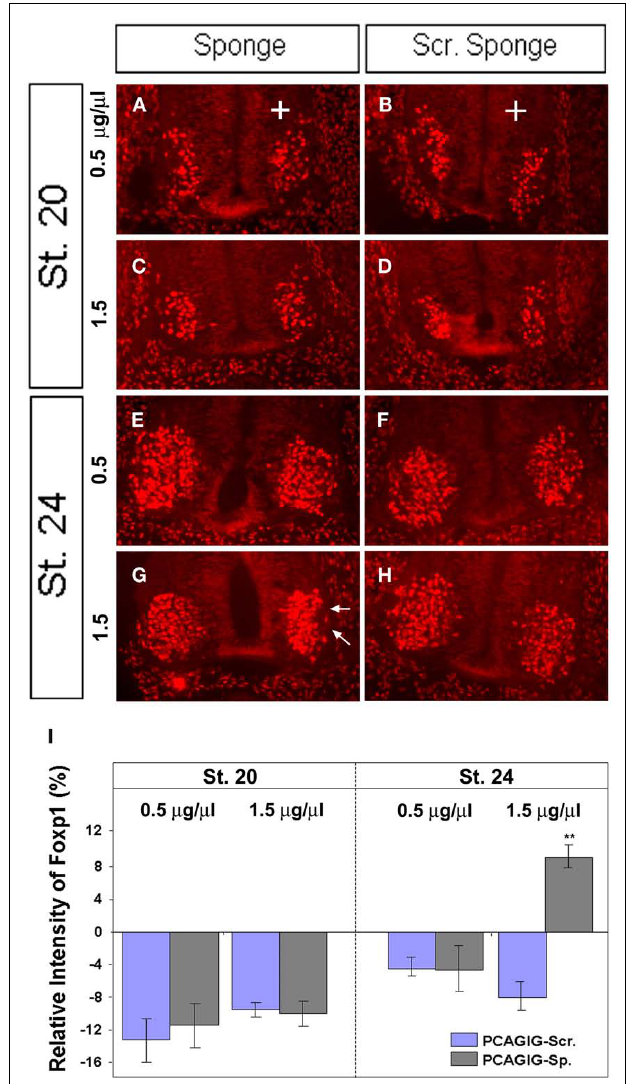
FIGURE 5 | miR-9 sponges release repression by endogenous miR-9 in a concentration dependent manner. (A + B) Electroporation of miR-9 sponges or scrambled sponges at low concentration (0.5 μ g/ μ l) showed no difference at HH 20. (C + D) Electroporation of miR-9 sponges or scrambled sponges at high concentration (1.5 μ g/ μ l) showed no difference at HH 20. (E + F) Electroporation of miR-9 sponges or scrambled sponges at low concentration showed no difference at HH 24. (G + H) Electroporation of miR-9 or scrambled sponges at high concentration. miR-9 sponge showed a significant increase in FoxP1 signal intensity at HH 24 (arrows). (I) Quantification of pixel intensity on the electroporated side compared to the non-electroporated side of the same spinal cord section. n > 5, ** p <